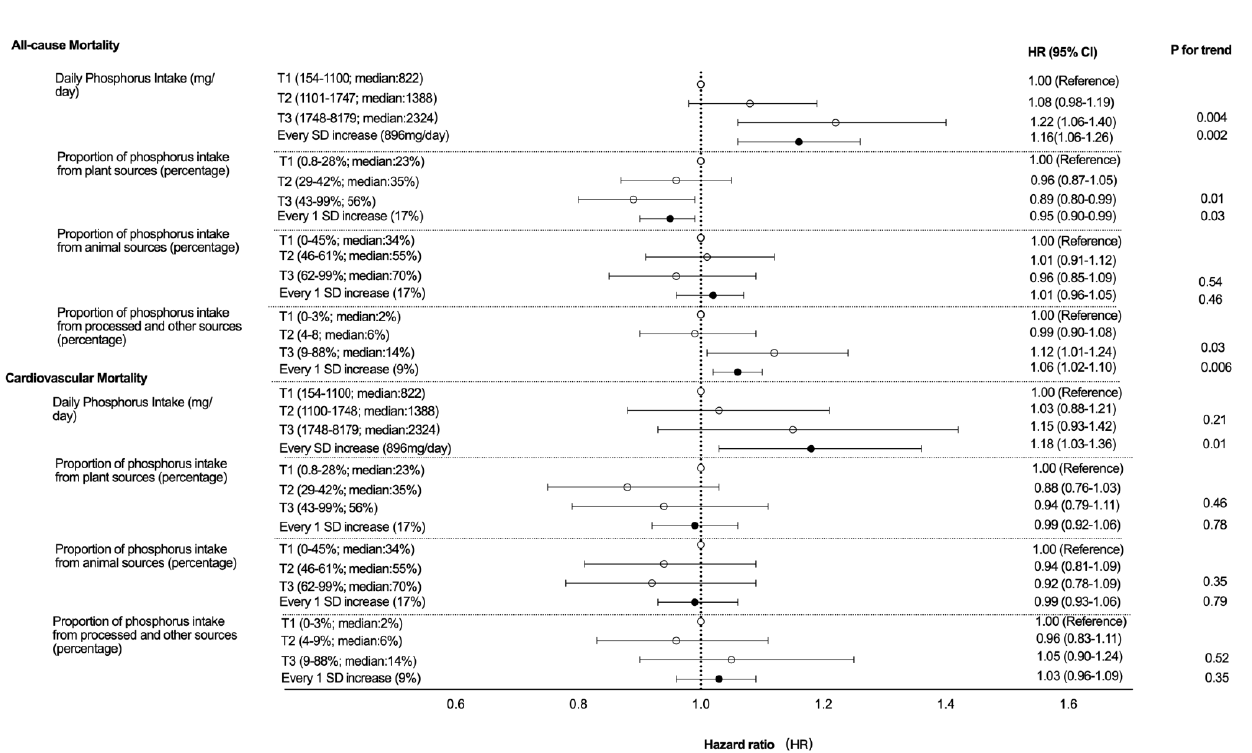
Figure 4. Forest plot of the adjusted association between the mortality and tertiles of total dietary phosphorus intake, and the proportion of phosphorus from plant, animal, and other sources. Multivariable Cox proportional hazard regression analyses fitted using a random ef- fects shared frailty model adjusted for age, sex, physical activity, smoking, body mass index, secondary education, history of cardiovascular disease, hypertension, diabetes, pulmonary disease, cancer, serum haemoglobin, serum albumin, serum calcium, statins, phosphate-binders (any or none), vascular access type (fistula versus graft/catheter), dial- ysis vintage, Kt/V, total energy intake per day and potassium intake gram per day, and Mediterranean diet score (we included the total daily phosphorus intake as the covariate when investigating the association between the proportion of phosphorus from specific sources and mortality). The analysis of cardiovascular mortality was additionally adjusted for alcohol consumption and antihypertensive drugs 3.3. Proportion of Phosphorus Intake from Different Sources and Mortality 3.3.1. Plant Sources Compared with patients in the lowest tertile of the proportion of phosphorus intake from plant sources (0.8 – 28%), the adjusted HRs for all-cause mortality among those in the middle (29 – 42%) and highest tertiles (43 – 99%) were 0.96 [95% CI, 0.87 – 1.05] and 0.89 (95%CI, 0.80 – 0.99), respectively ( p value per trend = 0.01). The adjusted HRs for cardio- vascular mortality were 0.88 [95% CI, 0.76 – 1.03] and 0.94 [95% CI, 0.79 – 1.11] for the mid- dle and highest tertiles of phosphorus intake from the plant sources, respectively ( p value per trend = 0.46). Every standard deviation (SD, 17%) increase in the proportion of phos- phorus intake from plant sources was associated with lower all-cause mortality (HR 0.95; 95%CI: 0.90 – 0.99), but not with lower cardiovascular mortality (HR 0.99; 95%CI, 0.92 – 1.06) (Figures 2 – 4).